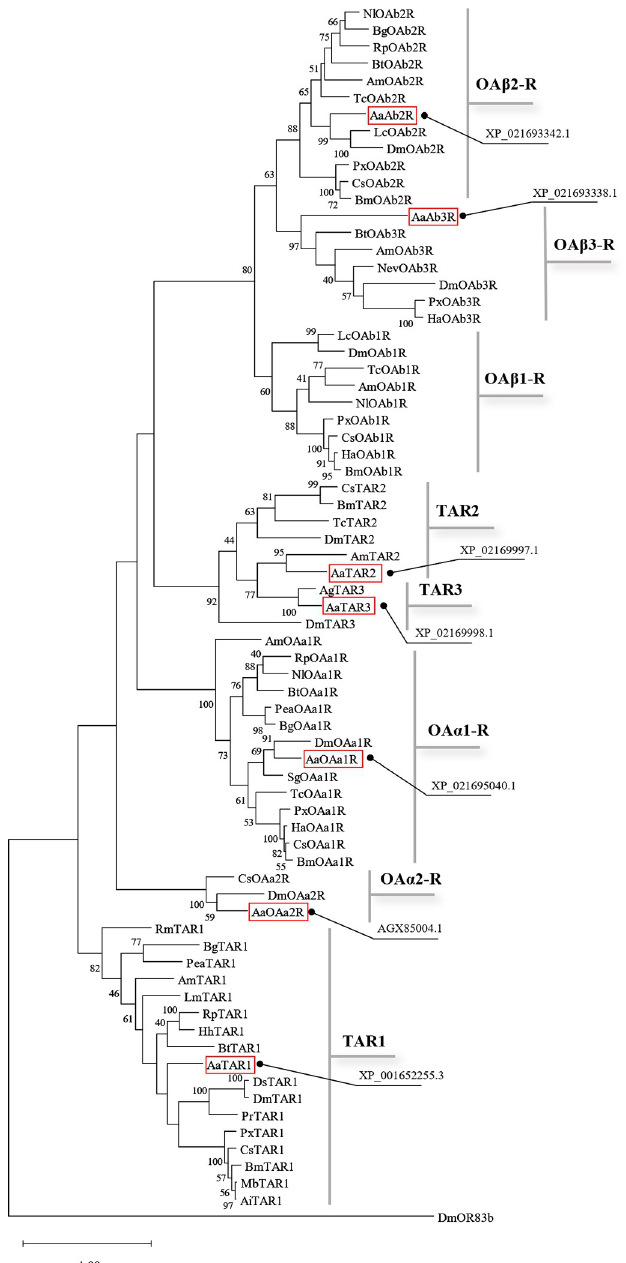
Fig 1. Phylogenetic relationship determined using maximum likelihood analysis of A . aegypti OA and TA receptors and other insect amine receptors. The characterized A . aegypti OA/TA receptors are outlined in red. The values shown at the nodes of the branches are the percentage bootstrap support (500 replications) for each branch. Alignment was performed using the amino acid sequences found in GenBank (accession number for each sequence is noted and reported in S2 Table). D . melanogaster OR83b receptor was chosen as